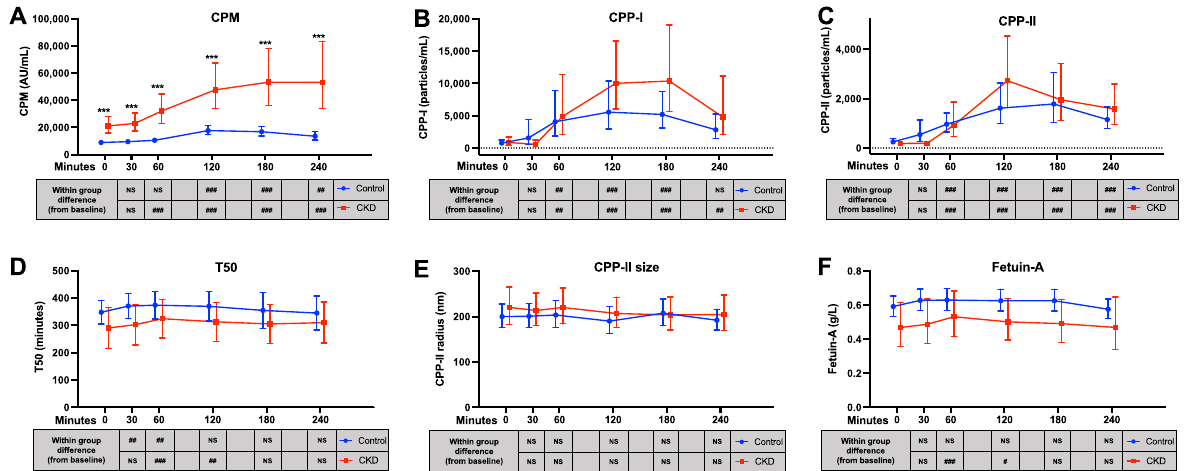
Figure 1. Post-prandial response of novel markers of mineral metabolism after standardised meal in participants with normal and impaired kidney function. Repeated measures of novel markers of mineral metabolism depicted for control and CKD group when fasting (“0”) and then post consumption of a standardised meal. Data are presented as mean and 95% confidence interval or geometric mean and 95% confidence interval. Data points have been offset for clarity. Between-group and within-group pairwise comparisons shown for each timepoint, with Bonferroni correction for multiple comparisons. (A) Calciprotein monomers (CPM); (B) primary calciprotein particles (CPP-I); (C) secondary calciprotein particles (CPP-II); (D) T50; (E) secondary calciprotein particle size (CPP-II size); (F) Fetuin-A. ***p < 0.001 for CKD group versus healthy controls. NS: p ≥ 0.05 versus group baseline; ##: p < 0.01 versus group baseline; ###: p < 0.001 versus group